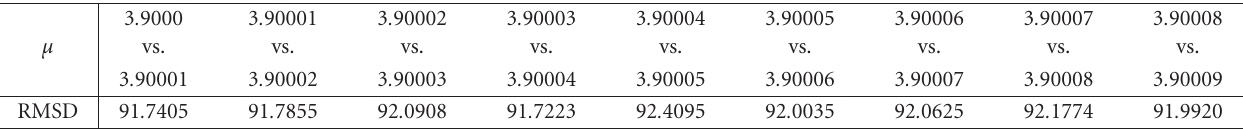
Table 3: The RMSD between the encryption results with x (0) = 0 . 75 and tiny fluctuation of 10 − 5 in µ . 3 .